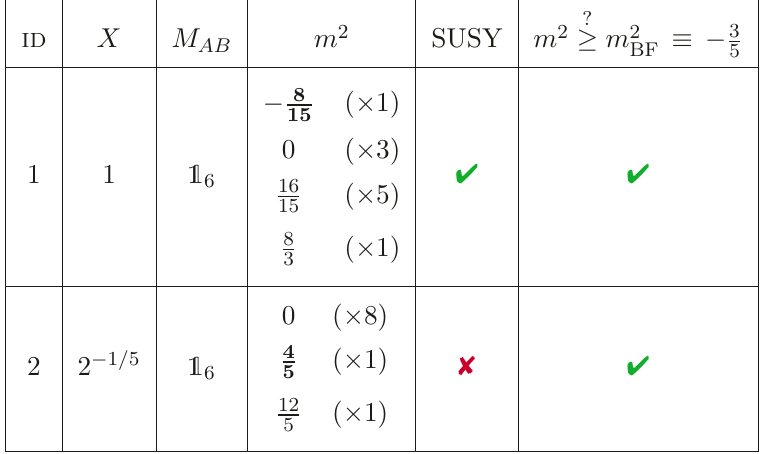
Table 3 . Properties of the two AdS 7 S 3 solutions in the closed sector. The values of the squared × masses are normalized to the cosmological constant and the correct (non-canonical) kinetic metric is taken into account. The two critical points can be identified by the value of the modulus X . The fifth column shows whether the solutions are supersymmetric ( ✔ ) or not ( ✘ ), while the last one whether all the masses of the 1 + 9 scalar dof’s are above the BF bound ( ✔ ), or not ( ✘